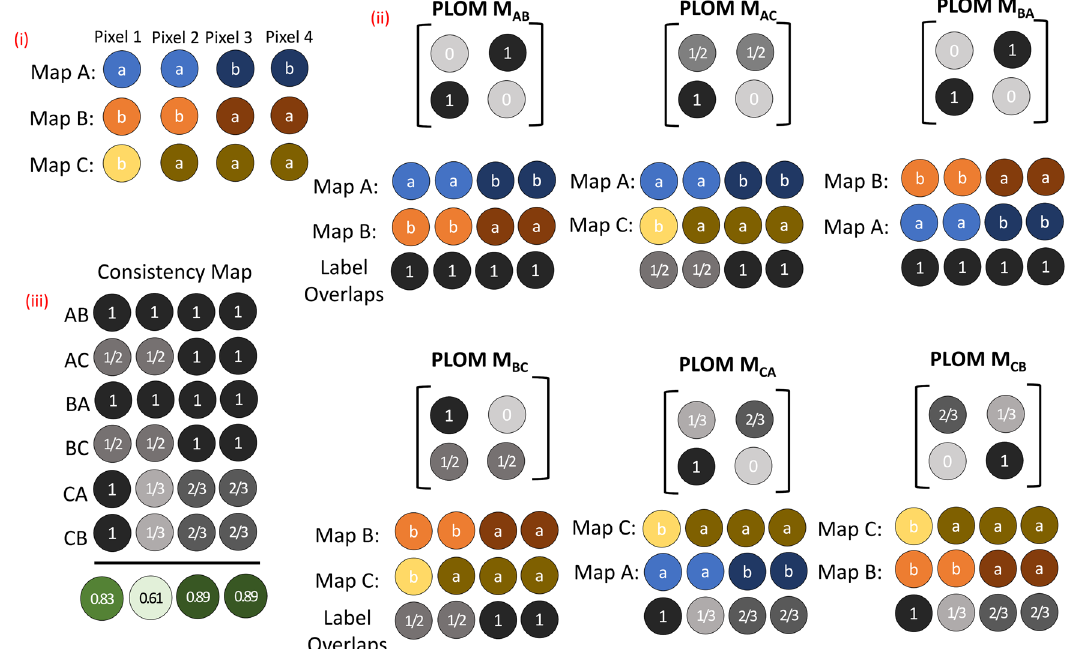
Fig. 7 An example of the procedure for calculating the statistical consistency map using 3 maps: Map A; Map B; and Map C (denoted by (i)). All the permutations of the ground truth map (the top row of each triplet of Map X, Map Y, label overlaps) and comparison map (the middle row of each triplet of Map X, Map Y, label overlaps) are given by (ii) along with the respective PLOM. For each pixel, the proportional label overlap is evaluated between the label of that pixel in the ground truth map and the label of that pixel in the comparison map (this can be done by simply referencing the appropriate element of the PLOM). The label overlaps for each of the ground truth map-comparison map pairs are then averaged in (iii) to give the fi nal statistical consistency map.